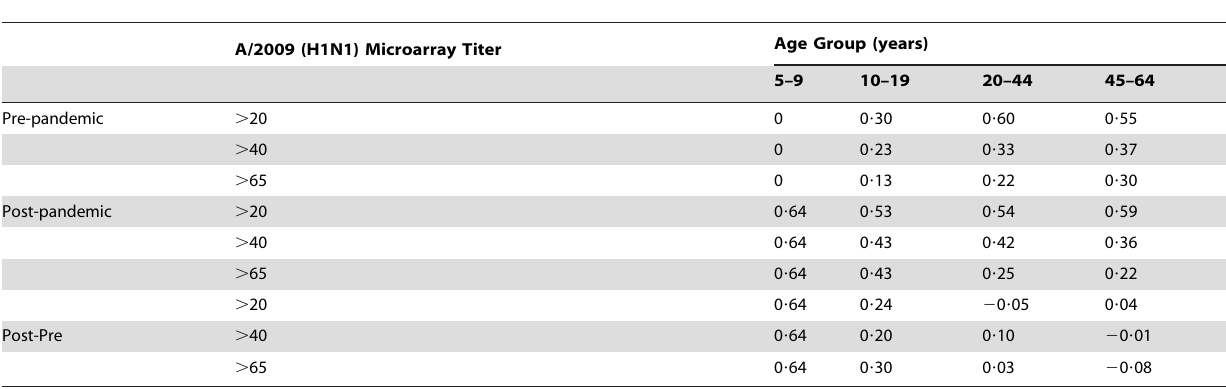
Table 2. Overview of the microarray data, stratified by age, cut-off for seropositivity, and study period (pre- versus post-